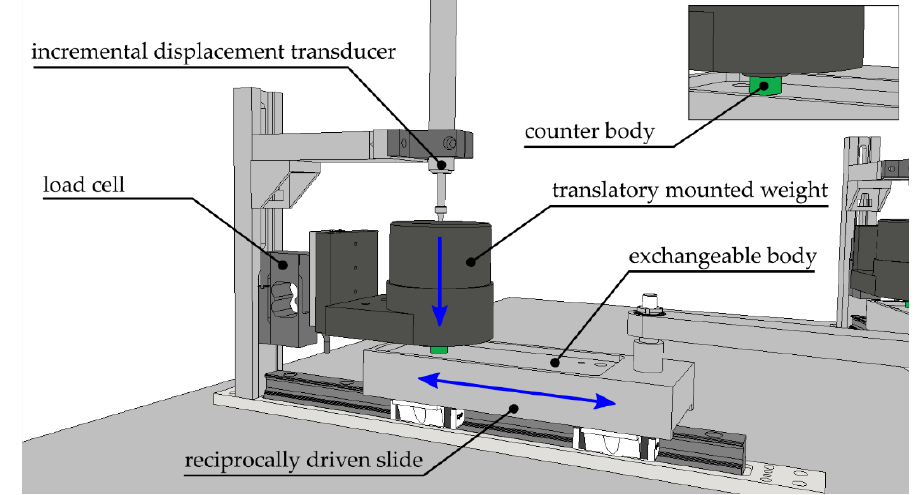
Figure 4. Structure of a reciprocal pin-on-plate measuring unit with wear measuring system.